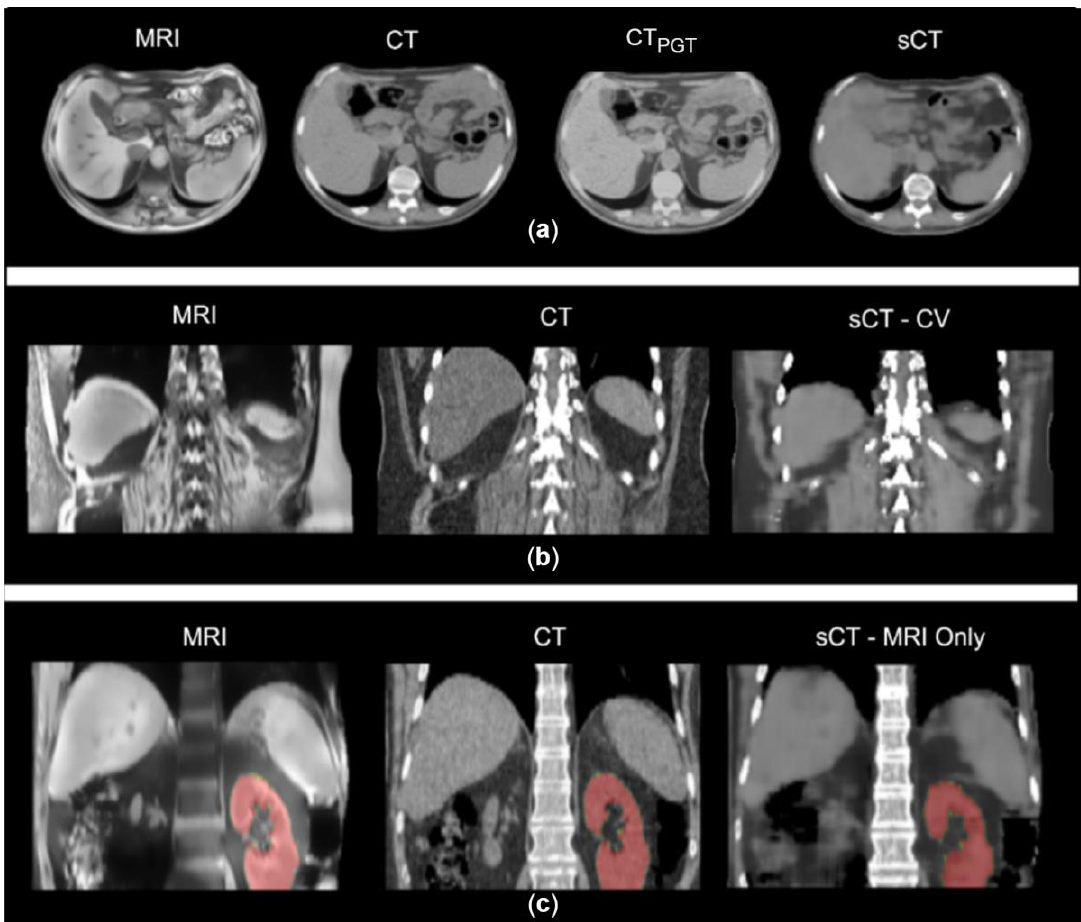
Figure 2. ( a ) Example of MRI, CT, sCT and pseudo ground truth (CT PGT ) on axial plane. CT PGT still shows visible discrepancies with MRI anatomical condition. ( b ) Example of inter-acquisition motion in a CT-MRI pair and the resulted sCT in CV. ( c ) Example of MRI, planning CT and synthetic CT from MRI-only scenario. In red, the segmentation of kidneys used for the geometrical analysis.